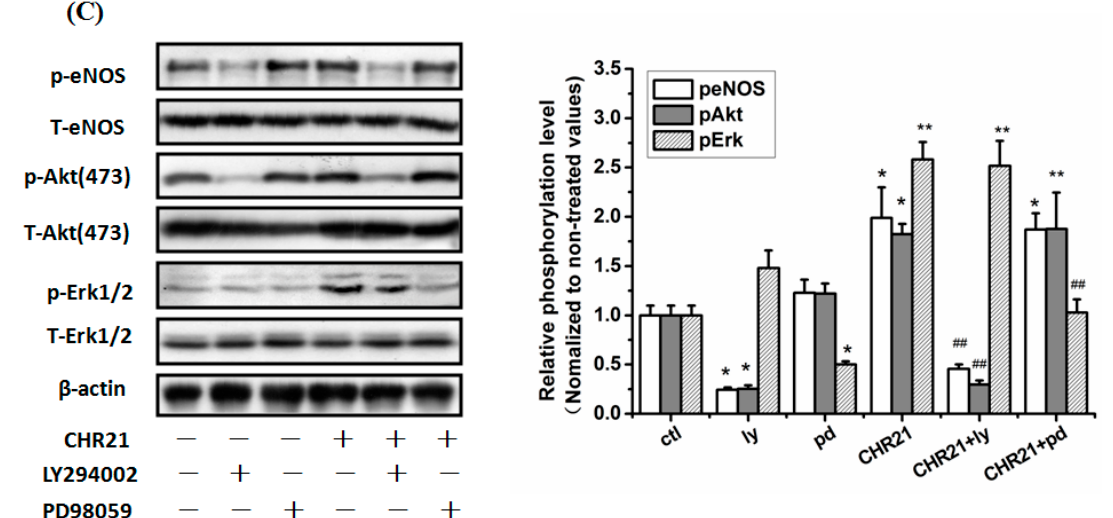
Figure 6. CHR20/CHR21 increase phosphorylation levels in PI3K/Akt and MEK/ERK1/2. RGC-5 cells were treated with 10 μ M CHR20 and CHR21 , repectively for 5–80 min or 0.3–30 μ M CHR20/CHR21 for 40 min. By applying Western blotting with antibodies including anti-phospho-Akt (Ser473), anti-phospho-ERK1/2, anti-phospho-and eNOS (Ser1177), respectively, the phosphorylation of the relevant proteins were determined. ( A ) CHR20 and CHR21 time-dependently increased the phosphorylation levels of Akt and ERK1/2 in RGC-5 cells; ( B ) CHR20 and CHR21 dose-dependently induced the phosphorylation of Akt and ERK1/2 in RGC-5 cells; ( C ) Effects of pathway inhibitors on the phosphorylation of Akt, eNOS and ERK1/2 affected by CHR21 . The density of the blot in each lane was presented as mean ± standard deviation. Each data was calculated based on at least three individual experiments. * p < 0.05, ** p < 0.01 vs. control group. # p < 0.05, ## p < 0.01 vs. CHR21 pre-treated group. Blots were quantified using ImageJ software. pd: PD98059; ly: